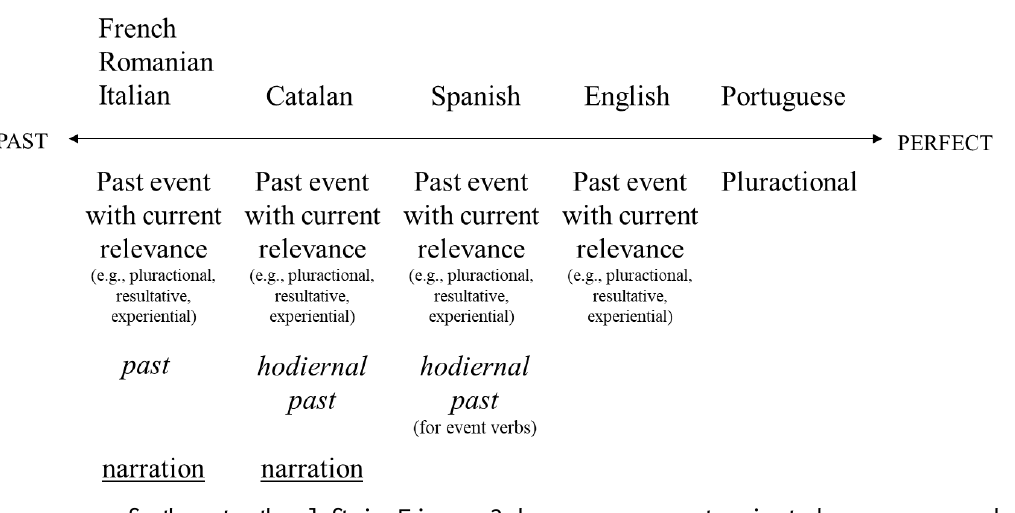
Figure 3 . Meaning ingredients underlying the PERFECT